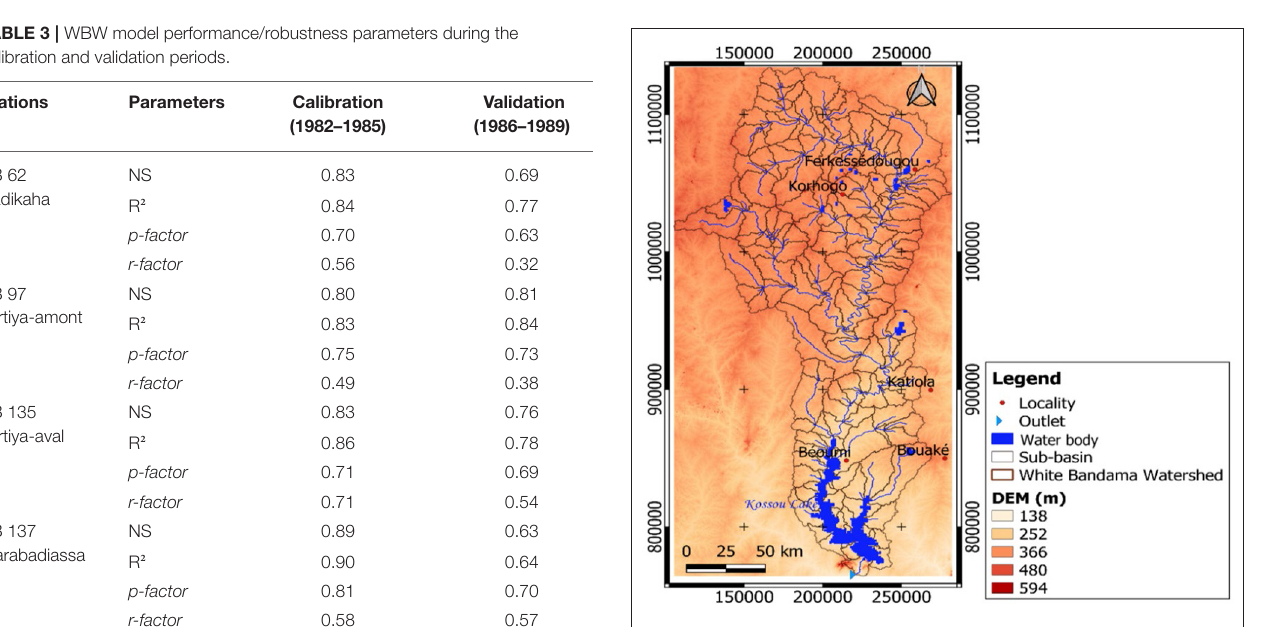
FIGURE 7 | Automatic extraction of the streamflow network, watershed outline, and sub-basins in the study area.